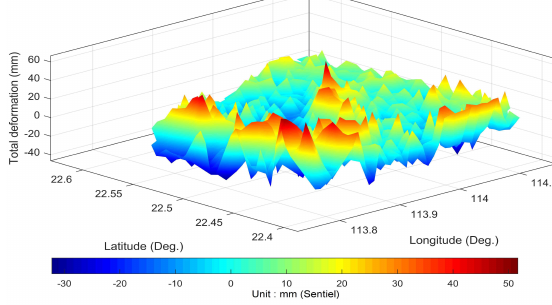
Figure 8. 3D deformation model of sentinel-1A